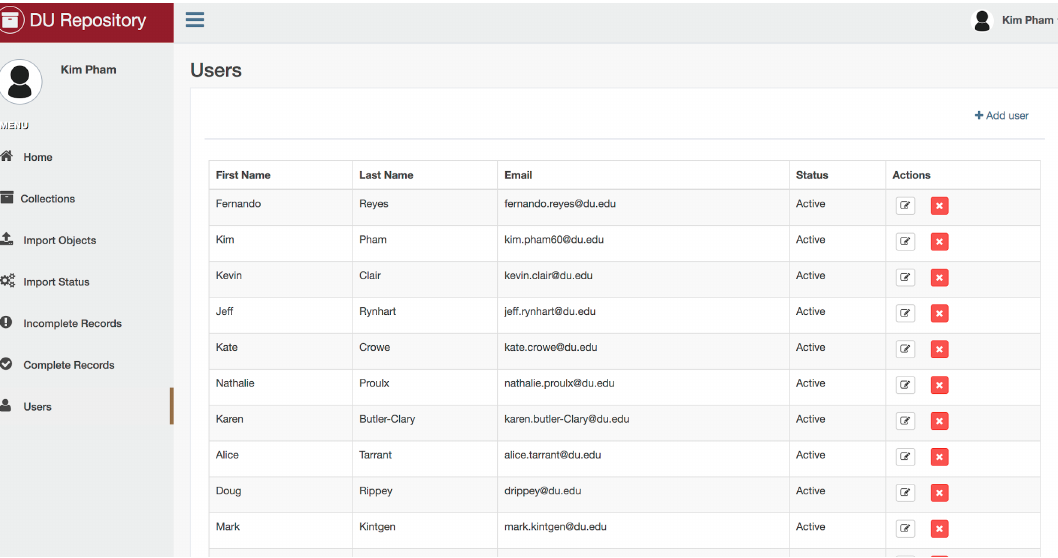
Figure A8. Users module.